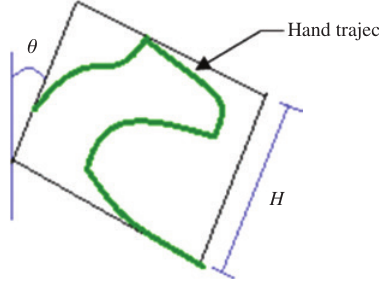
Figure 7: Temporal Feature Extraction. Computation of height ( H ) and orientation ( θ